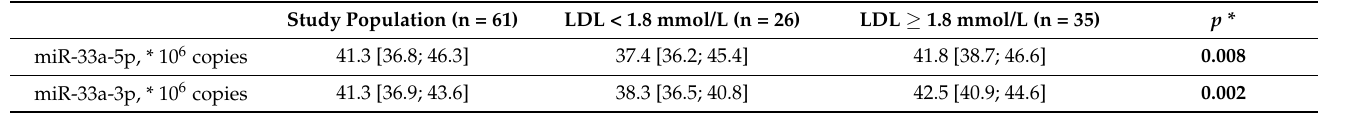
Table 3. miR-33a expression levels by group.